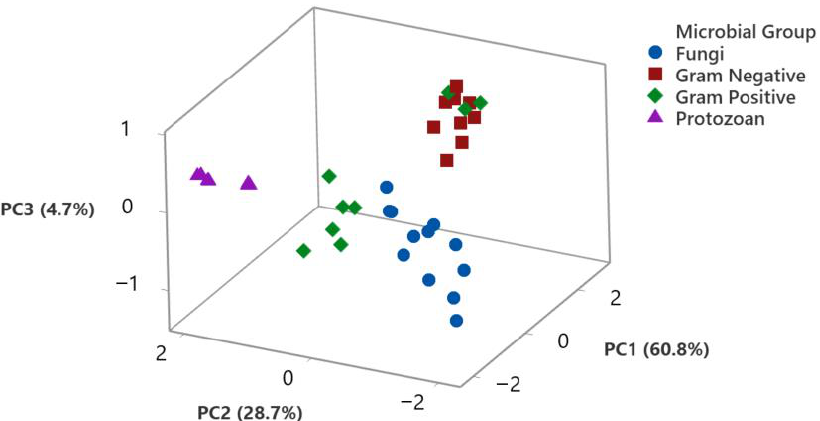
Figure 4. Principal Component Analysis (PCA) for the biological activity of essential oils against the different microorganisms analyzed. Scores for each microorganism for the first three PCA are shown.